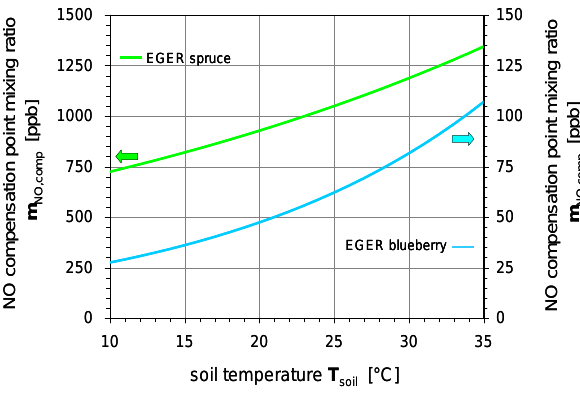
Figure 21. Soil temperature dependence of NO compensation point mixing ratio ( m NO , comp ) for EGER blueberry and EGER spruce Fig. 21: Soil temperature dependence of NO compensation point mixing ratio ( m NO,comp ) for “EGER blueberry” and “EGER spruce” samples. The curves have been samples. The curves have been calculated using the P NO (θ 0 , T 0 calculated using the P NO (  0 , T 0 ), k NO (  0 , T 0 ), Q 10_P,NO , and Q 10_U,NO -data listed in Table 2.